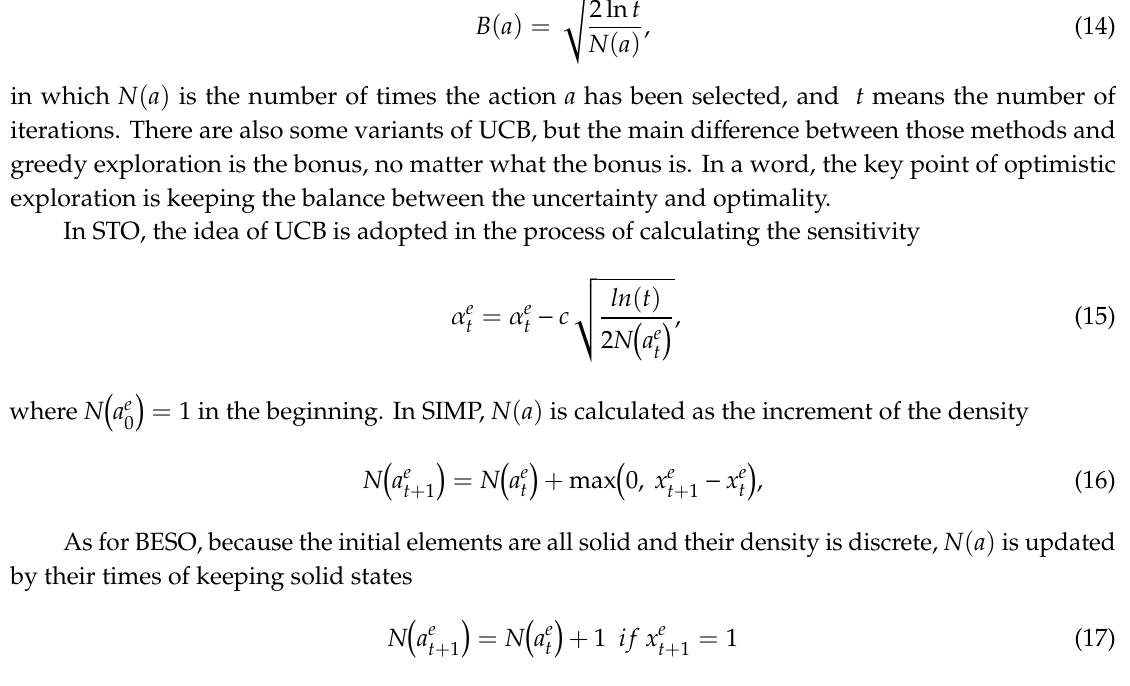
Figure 3. Search windows of different sizes.